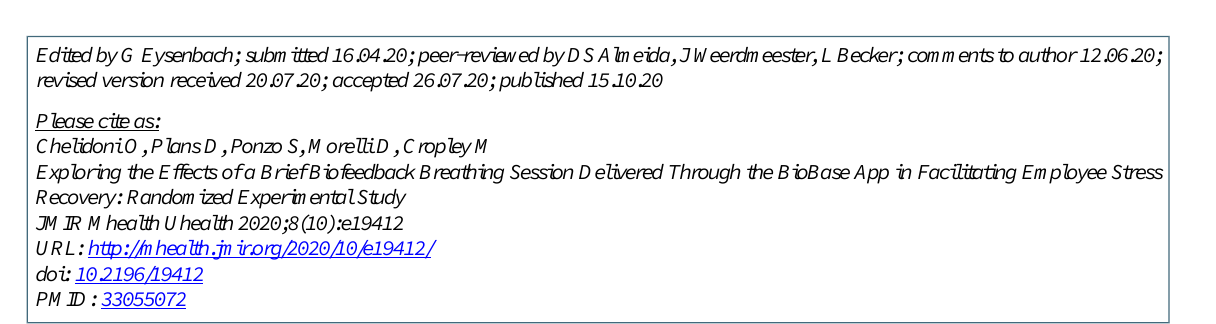
RMSSD: root mean square of successive RR interval differences RR: interbeat RSA: respiratory sinus arrhythmia VAS: Visual Analog